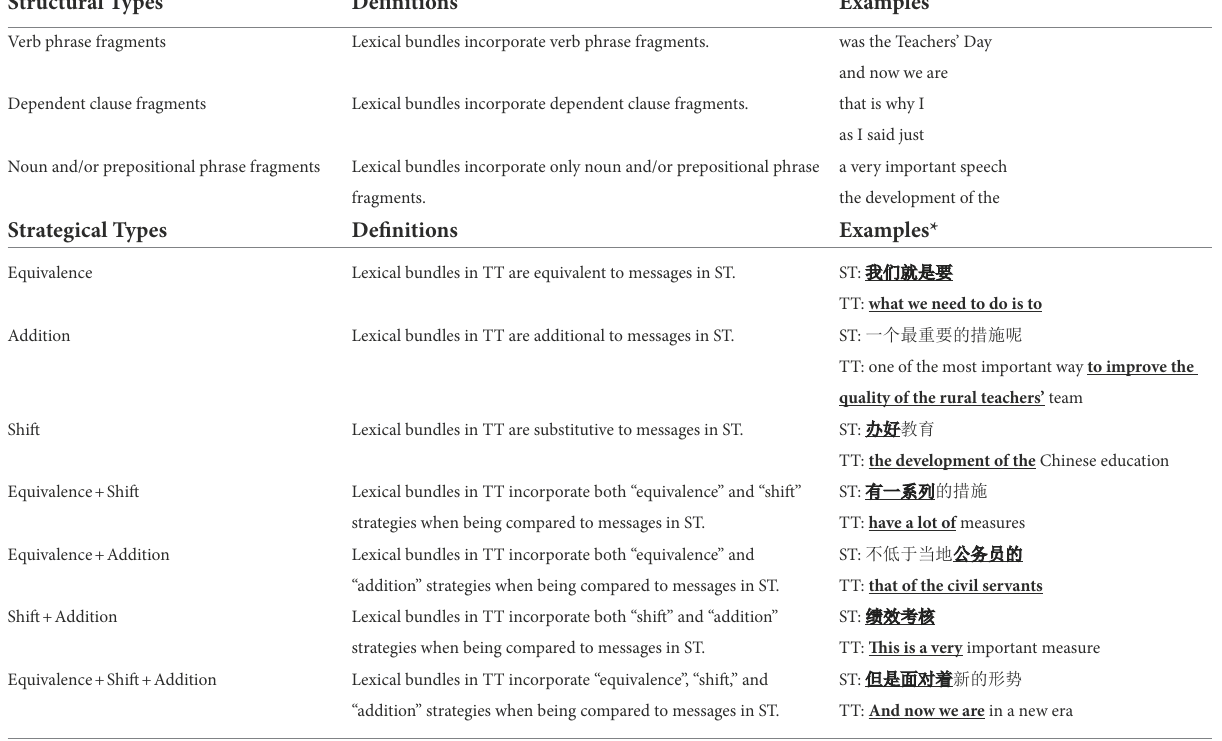
TABLE 1 Definitions and examples of structural and strategical types of lexical